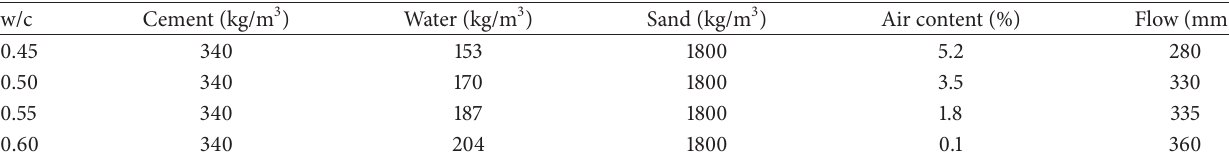
Table 1: Mix proportions.